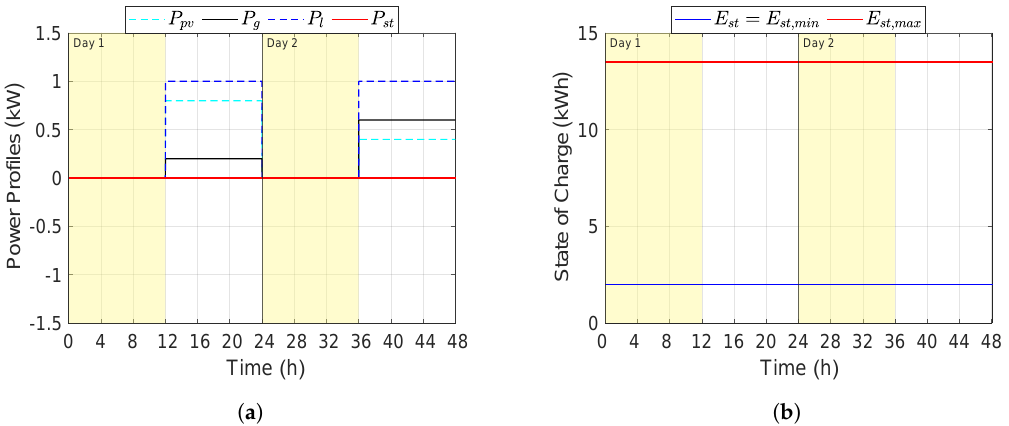
Figure 6. Simulation results given by the heuristic strategy considering a simple scenario. On the left power profiles are given, on the right the state of charge is reported: ( a ) Power Profiles; ( b ) State of Charge.